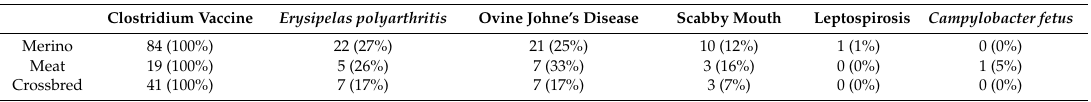
Table 3. Vaccination type administered to ewes pre-lambing by breed from 114 NSW sheep producers who identified to vaccinate in a 2019 NSW survey.